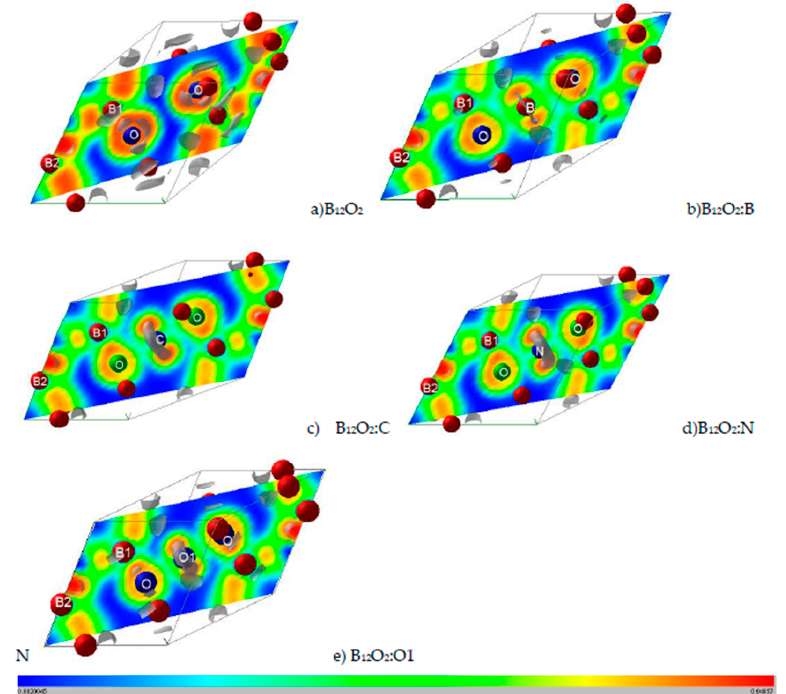
Figure 2. (color). ELF slice planes along diagonal plane. ( a ) B 12 O 2 , ( b ) B 12 O 2 :B, ( c ) B 12 O 2 :C, ( d ) B 12 O 2 :N, and ( e ) B 12 O 2 :O or B 12 O 3 . The ruler shows the color code with blue, green, and red corresponding respectively to 0 (no electron localization), ½ (free electron like), and 1 (full electron localization). Grey volumes depict 3D ELF, especially for showing the non-bonded electrons around central inserted atoms: C, N, and O. In the post-treatment process of the ground state electronic structures, the total charge densities “CHGCAR”, as well as the magnetic charge density “CHGCAR_magn” are illustrated. The latter is computed if spin polarized SP calculations identify a mag- netic solution, versus nonmagnetic NSP configuration. From the geometry of the ground state structures NSP and SP, the detailed elec- tronic site and spin projected density of states (PDOS) were obtained within DFT using full potential augmented spherical wave (ASW) method [25] and the GGA for the XC effects [17]. Also, the properties of chemical bonding are qualitatively assessed within ASW based on overlap matrix (S ij ) with the crystal orbital overlap population (COOP) criterion [26]. In short hand notation, the COOP’s are the S ij —weighted density of states (DOS). Positive, negative and zero COOP magnitudes (cf. Section 4) correspond to bonding, anti-bonding and non-bonding interactions. In the minimal ASW basis set, the outermost shells were chosen to represent the valence states and the matrix elements. They were constructed using partial waves up to l max = 1 for B, O, and X p-elements interstitials. In the most electronegative element, oxy- gen’s low energy lying 2s states were omitted from the valence basis set in the DOS pro- jection for the sake of clarity. Self-consistency was achieved when charge transfers and energy changes between two successive cycles were: Δ Q < 10 − 8 and Δ E < 10 − 6 eV, respec- tively. The Brillouin-zone integrations were performed using the linear tetrahedron method within the irreducible rhombohedral wedge following Blöchl et al. scheme [20].